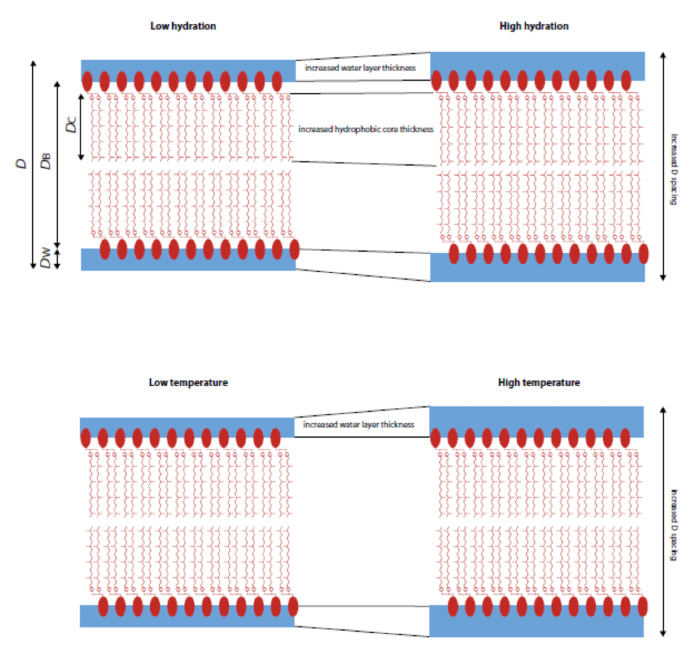
Figure 6. Schematic summary of the e ff ects of hydration and temperature on the bilayer membranes. Supplementary Materials: Supplementary materials can be found at http: // www.mdpi.com / 1422-0067 / 21 / 5 / 1816 /